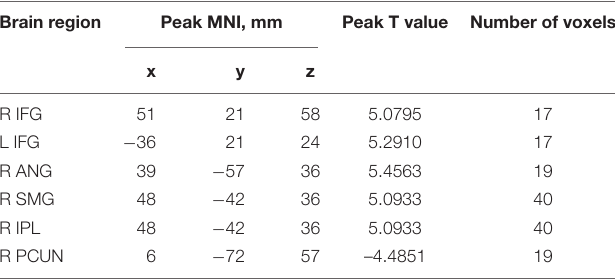
TABLE 2 | Regions revealing significant ALFF differences between IXT patients and HCs ( P < 0.05, corrected for GRF). Brain region Peak MNI, mm Peak T value Number of voxels